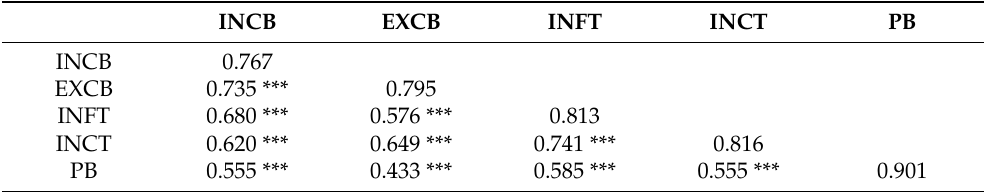
Table 3. Discriminant validity test